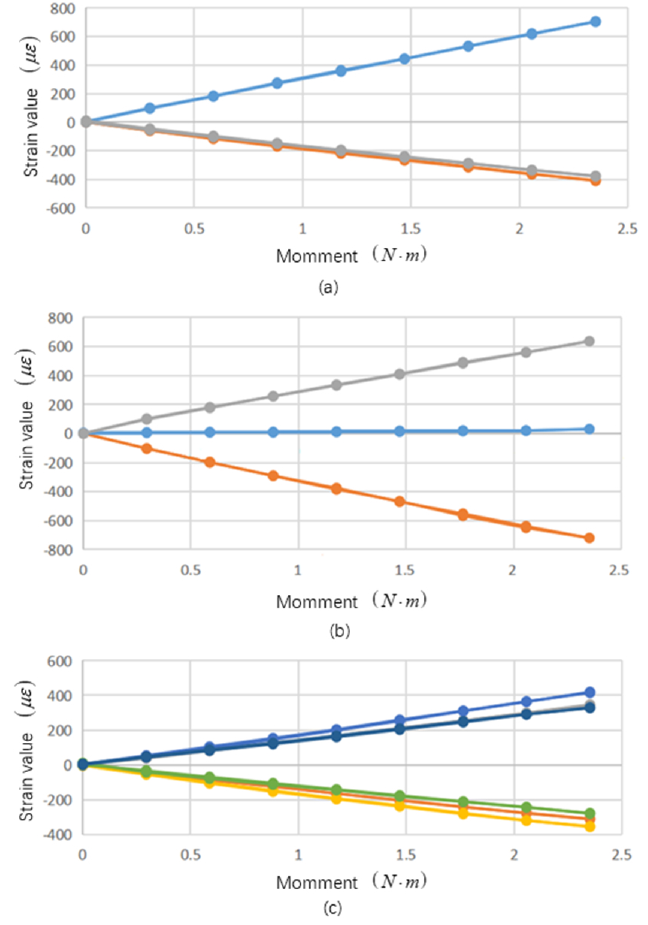
Figure 7. Correspondence between strain values and load. ( a ) x axis direction. ( b ) y axis direction. ( c ) z axis